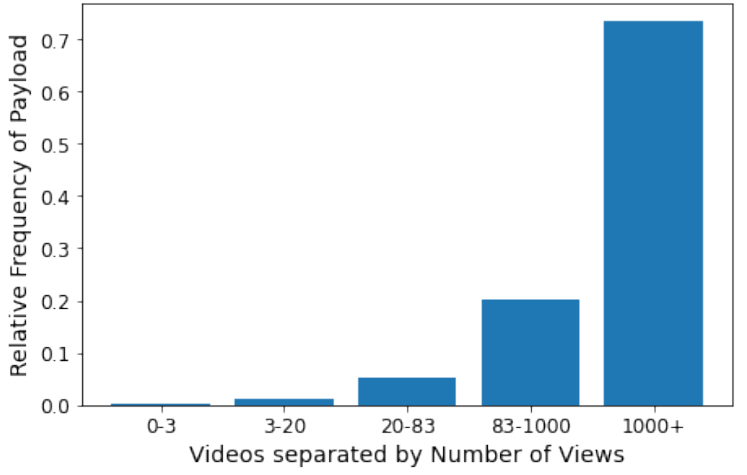
Figure 5. Percentage of total payload separated by five classes of number of views.